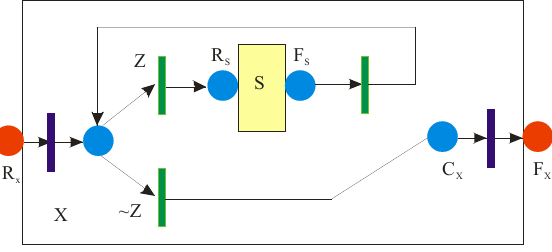
Fig.6. The service net for BPEL while pattern